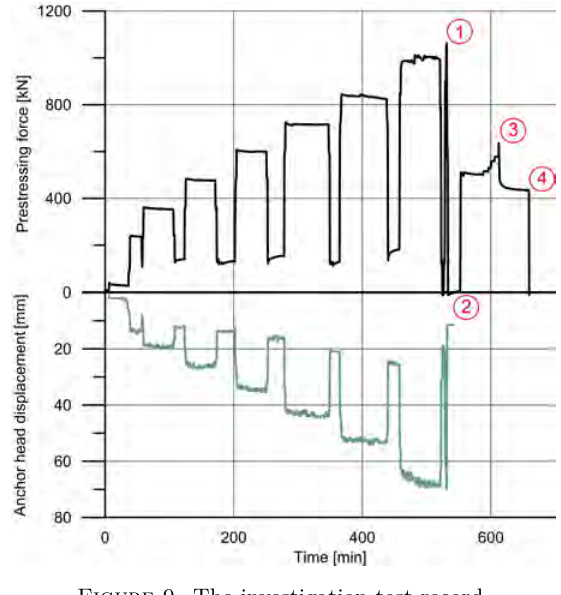
Figure 9. The investigation test record.